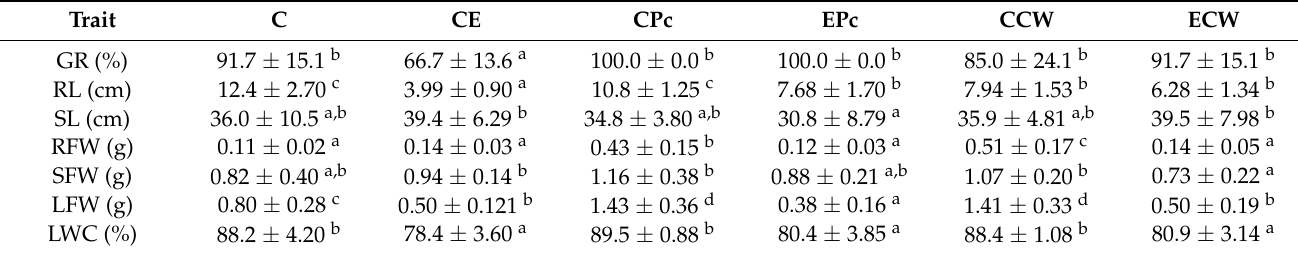
Table 3. Effect of soil treatments on plant growth parameters. Soil sampled in the Chinampas area was used as control (C); soil contaminated with endosulfan (CE); control soil bioremediated with Penicillium crustosum (CPc); endosulfan- contaminated soil, bioremediated with P. crustosum (EPc); control soil bioremediated with citric waste (CCW); endosulfan- contaminated soil, bioremediated with citric waste (ECW). Growth parameters abbreviations: germination rate (GR); root length (RL); stem length (SL); root fresh weight (RFW); stem fresh weight (SFW); leaf fresh weight (LFW); leaf water content (LWC). Values represent the means of five replicas (five individual plants) followed by SD. Different letters in each row indicate significant differences between treatments, according to the Tukey test at the 99% confidence